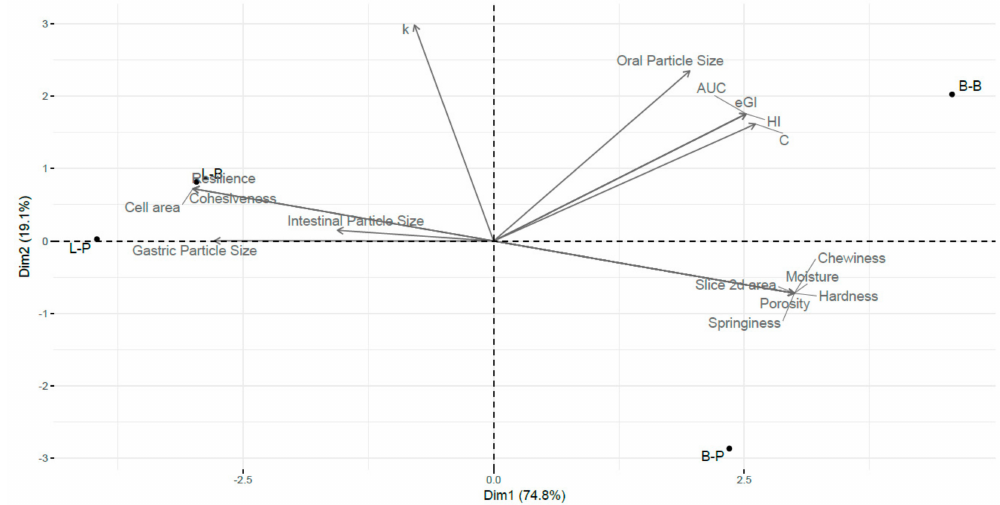
Figure 5. Score and loading biplot Dimension 1 × Dimension 2 of samples and variables obtained by principal component analysis (PCA). Samples are labelled as in the